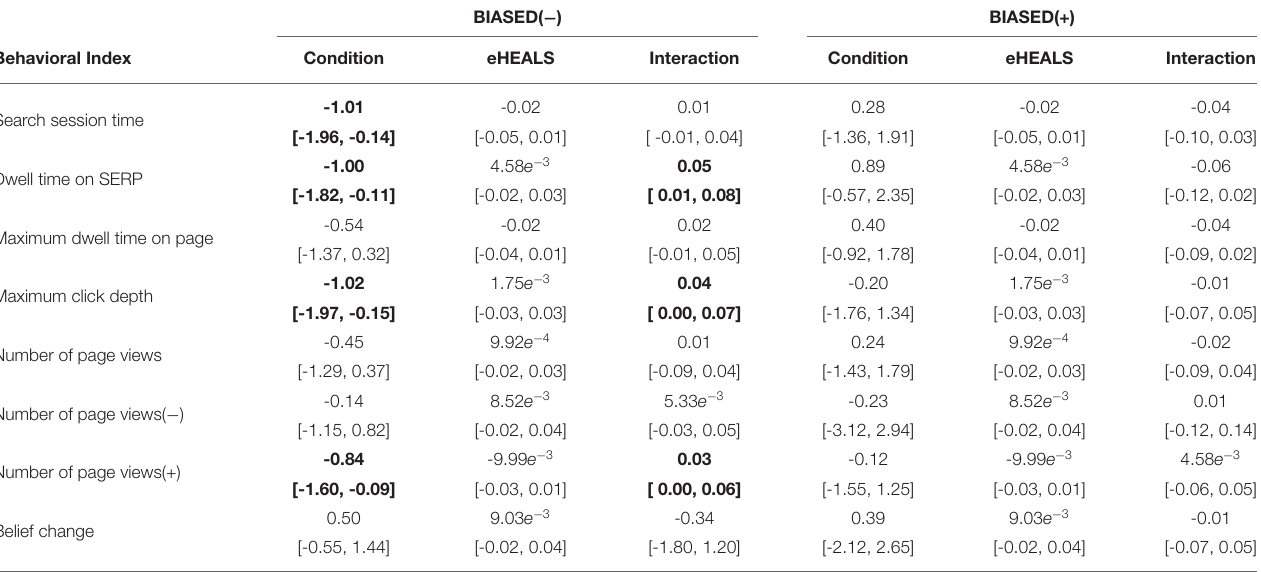
TABLE 2 | GLMM results compared to neutral